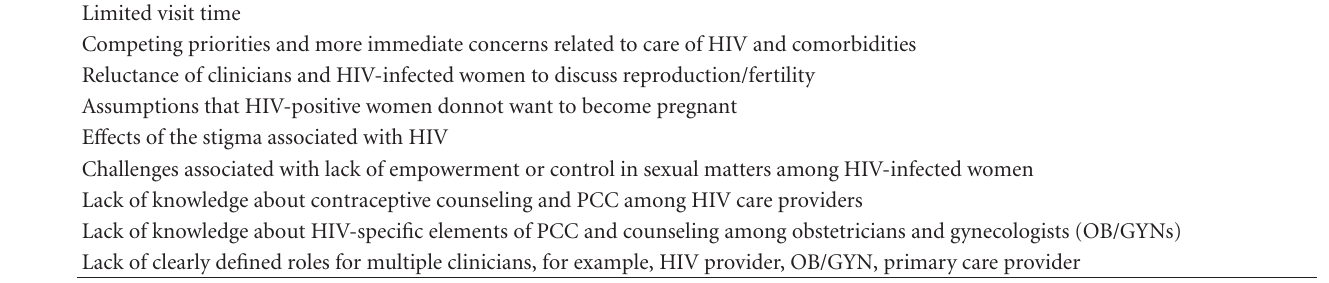
Table 3: Potential barriers to preconception counseling and care for women living with HIV. Limited visit time